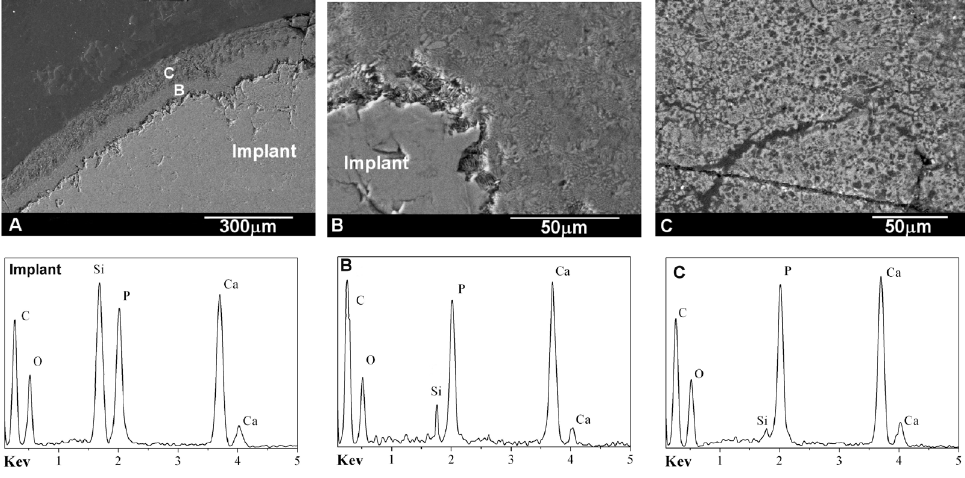
Figure 7. Back-scattered SEM images and EDS analyses of the cross-section of Bioeutectic implant showing the new bone tissue in direct contact with the implant after four months of implantation.